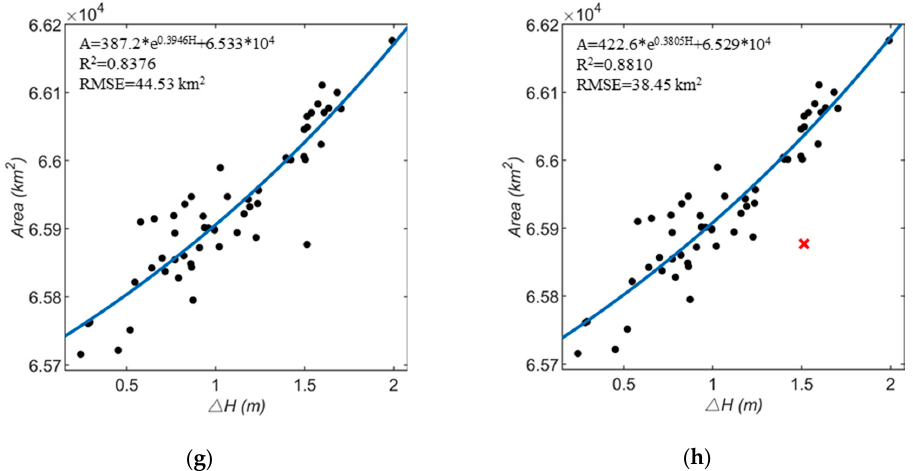
Figure 8. Area - ∆ H relationship models: ( a ) linear regression before excluding outliers; ( b ) linear regression after excluding outliers; ( c ) polynomial regression before excluding outliers; ( d ) polynomial regression after excluding outliers; ( e ) power regression before excluding outliers; ( f ) power regression after excluding outliers; ( g ) exponential regression before excluding outliers; ( h ) exponential regression after excluding outliers.